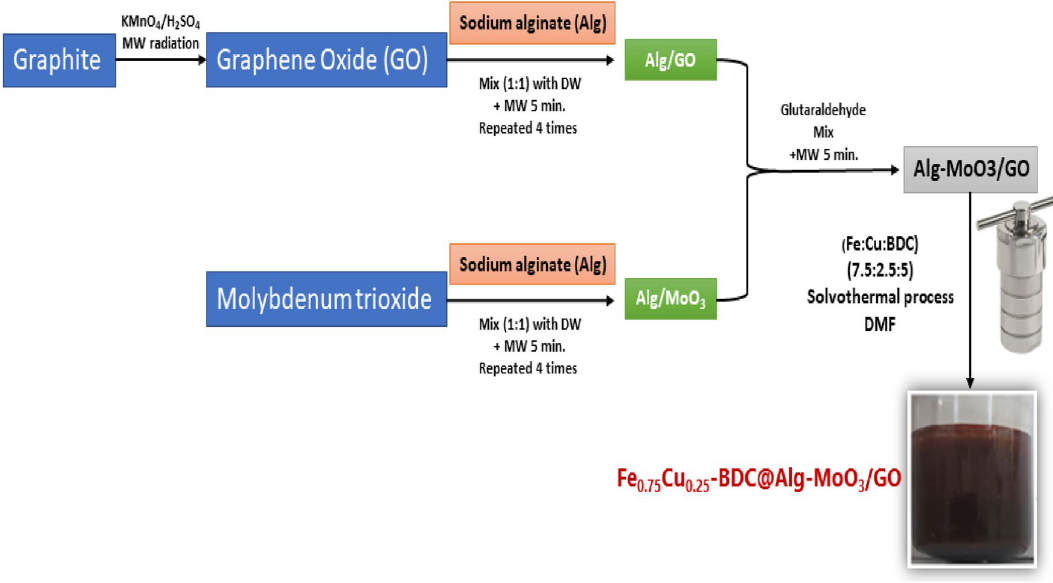
Figure 1. Preparation of Fe 0.75 Cu 0.25 -BDC@Alg-MoO 3